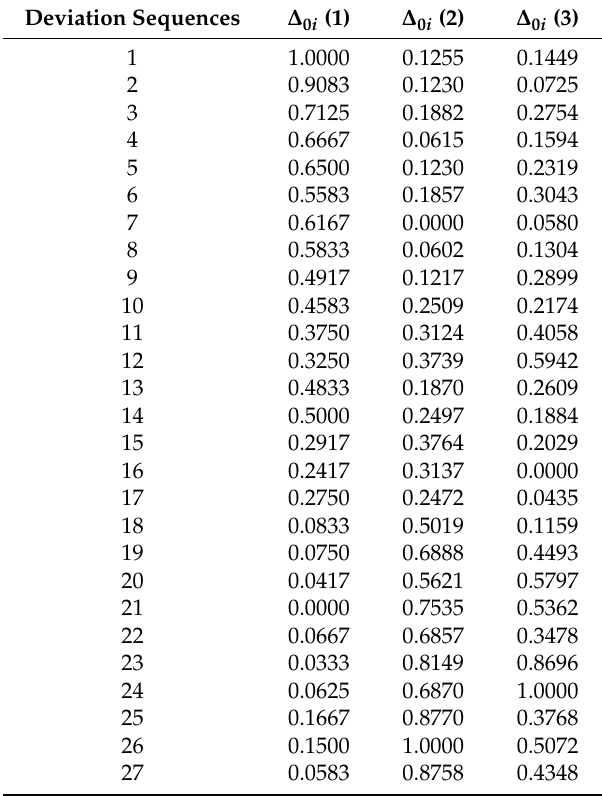
Table 10. The deviation sequences.